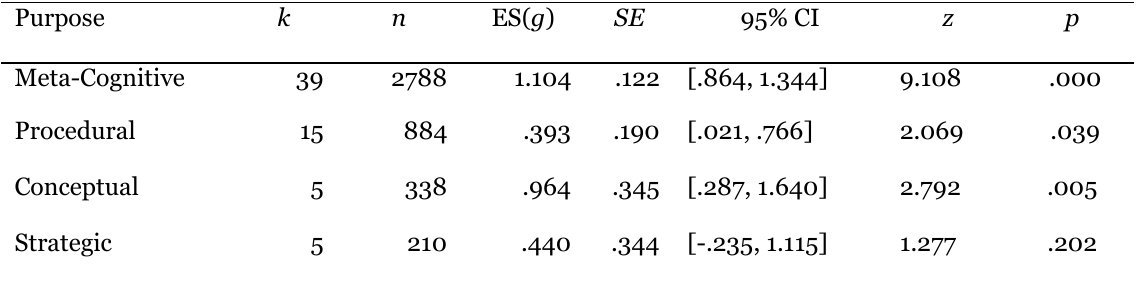
Effect Sizes and Confidence Interval for Scaffolding Purposes